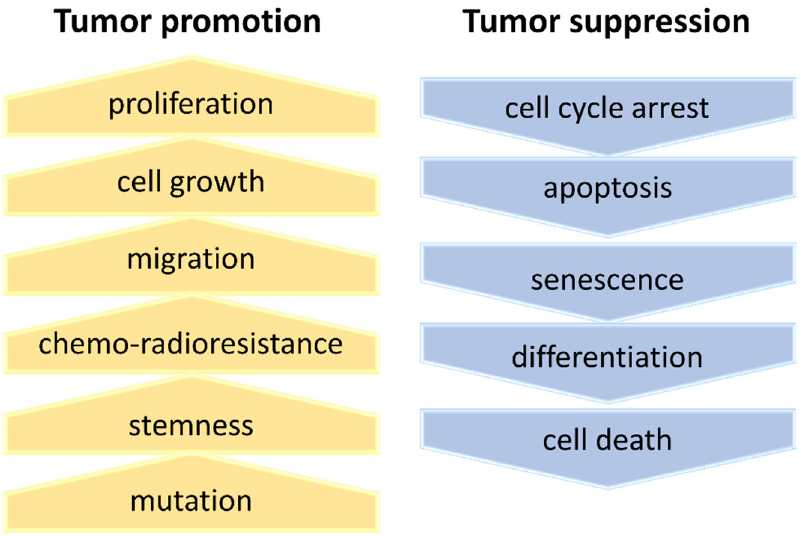
Figure 5. Extra-ribosomal function in cancer. The deregulation of ribosome biogenesis induces tumor-promotive and -suppressive functions.